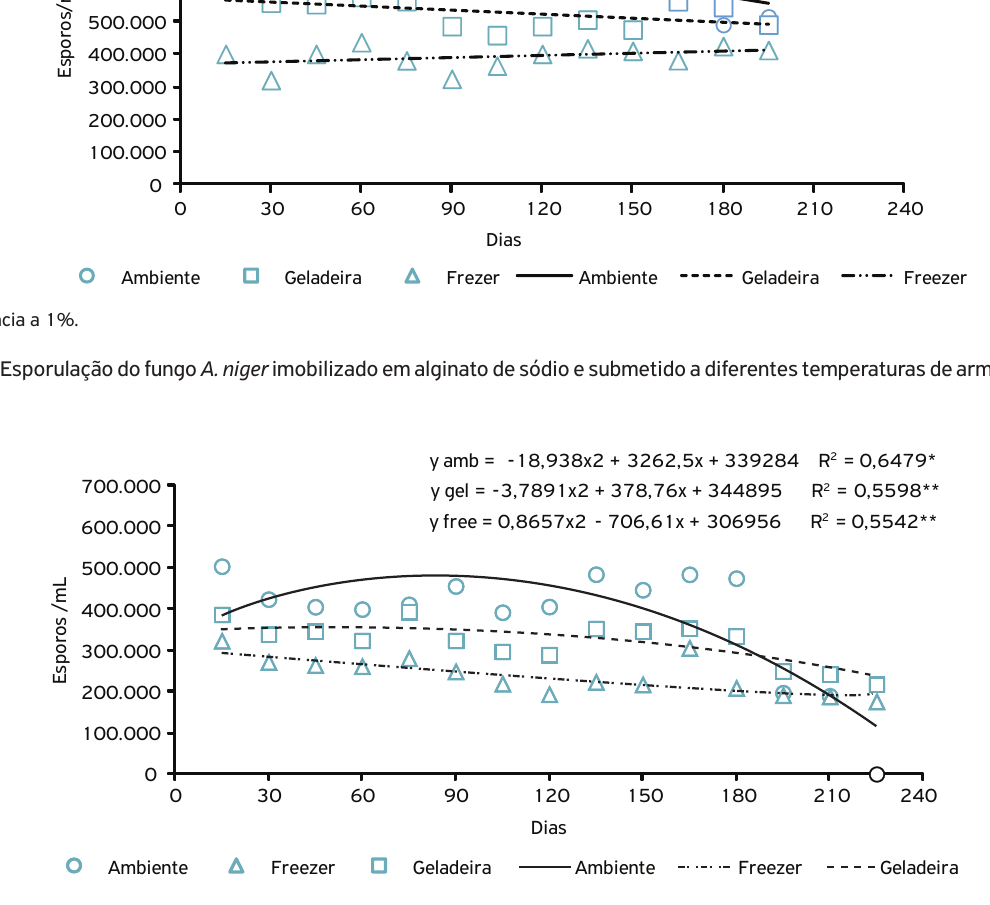
Figura 5. Esporulação do fungo C. cladosporioides imobilizado em alginato de sódio e armazenado em diferentes temperaturas.